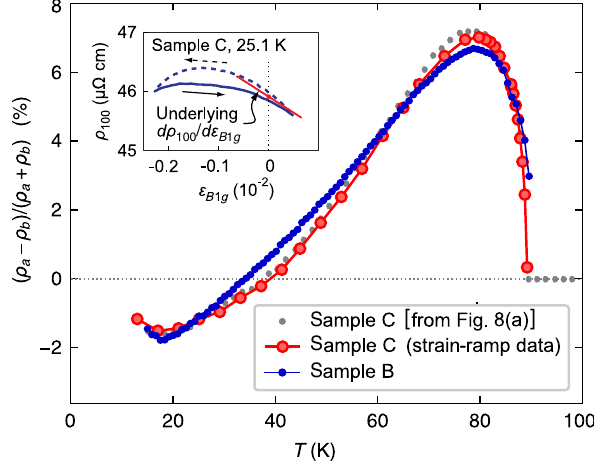
− ρ Þ = ð ρ þ ρ Þ of a b a b ¼ 0 , as shown in B 1 g